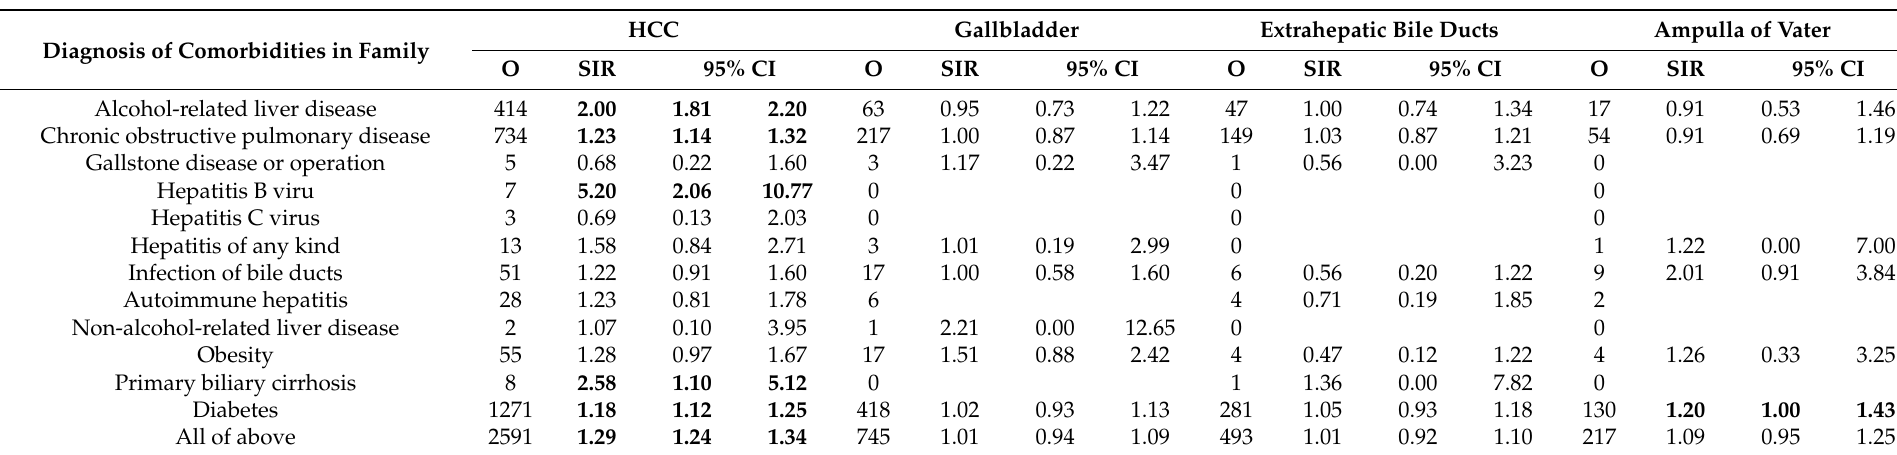
Table 7. Familial risks of specific hepatobiliary cancer when family members were diagnosed with comorbidities,